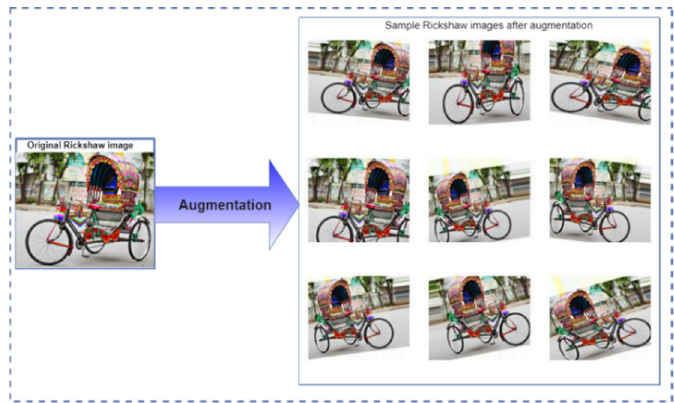
Figure 3. Techniques of data augmentation performed on sample